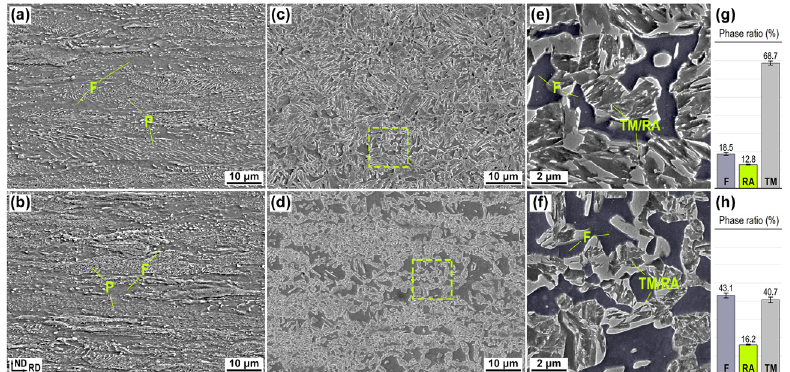
Figure 1. Microstructure and phase ratio of the investigated steels. The initial microstructures prior to QP processing of ( a ) QP1.7Si and ( b ) QP2.5Si. Microstructures after QP processing of ( c ) QP1.7Si and ( d ) QP2.5Si; ( e , f ) show the microstructure details within the dashed box in ( c , d ), respectively. Phase ratio of ( g ) QP1.7Si and ( h ) QP2.5Si. F, P, TM, and RA denote ferrite, pearlite, tempered martensite, and retained austenite, respectively. Ferrite grains are superimposed in purple. ND and RD denote the normal direction and rolling direction,